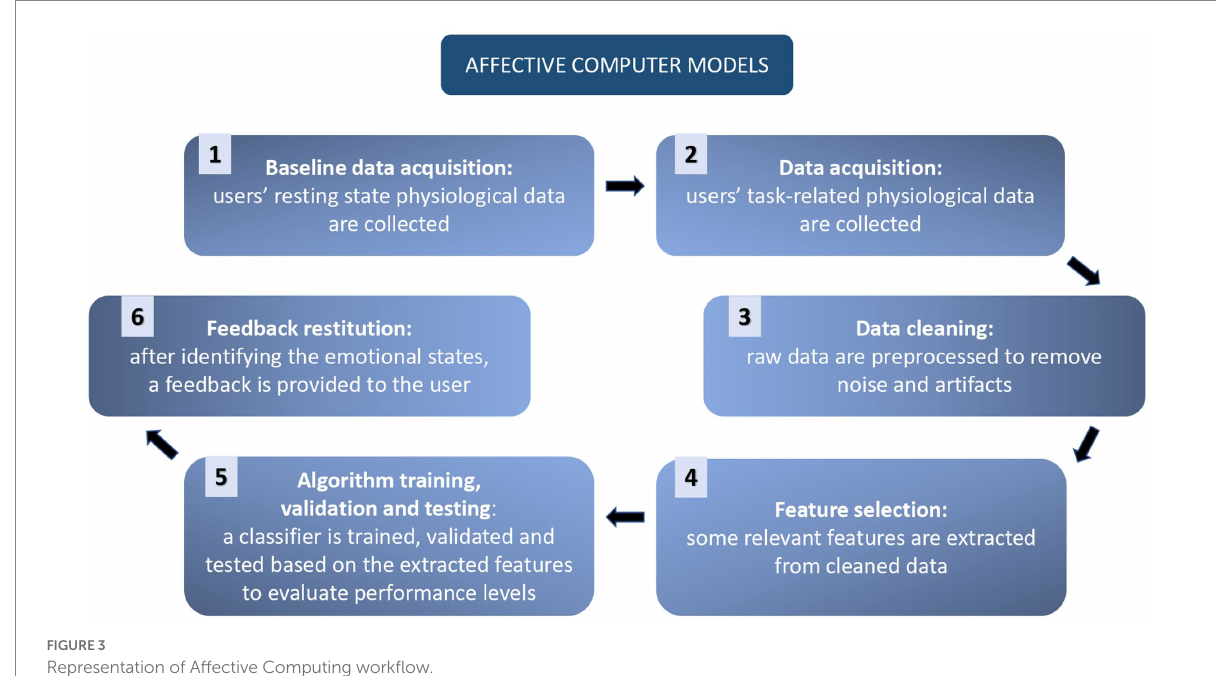
FIGURE 3 Representation of Affective Computing